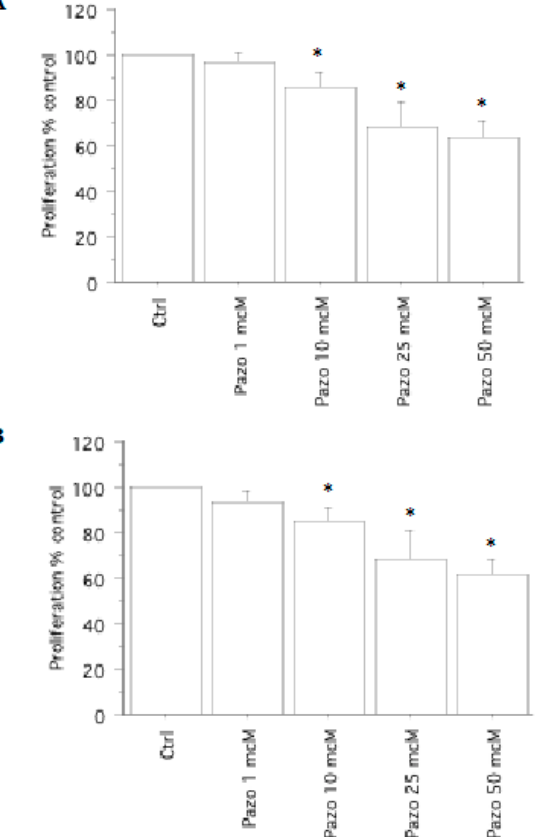
Figure 2. Cell proliferation in pATC cells. WST-1 assay in pATC cells with ( A ) or without ( B ) V600E BRAF mutation, treated with pazopanib (1, 10, 25, or 50 µM) for 24 h. The pATC cell proliferation was significantly reduced vs. control (Ctrl). The obtained results were similar in tumors in presence/absence of the V600E BRAF mutation. Bars represent the mean ± SD. * p < 0.05 vs. control according to Bonferroni–Dunn test.